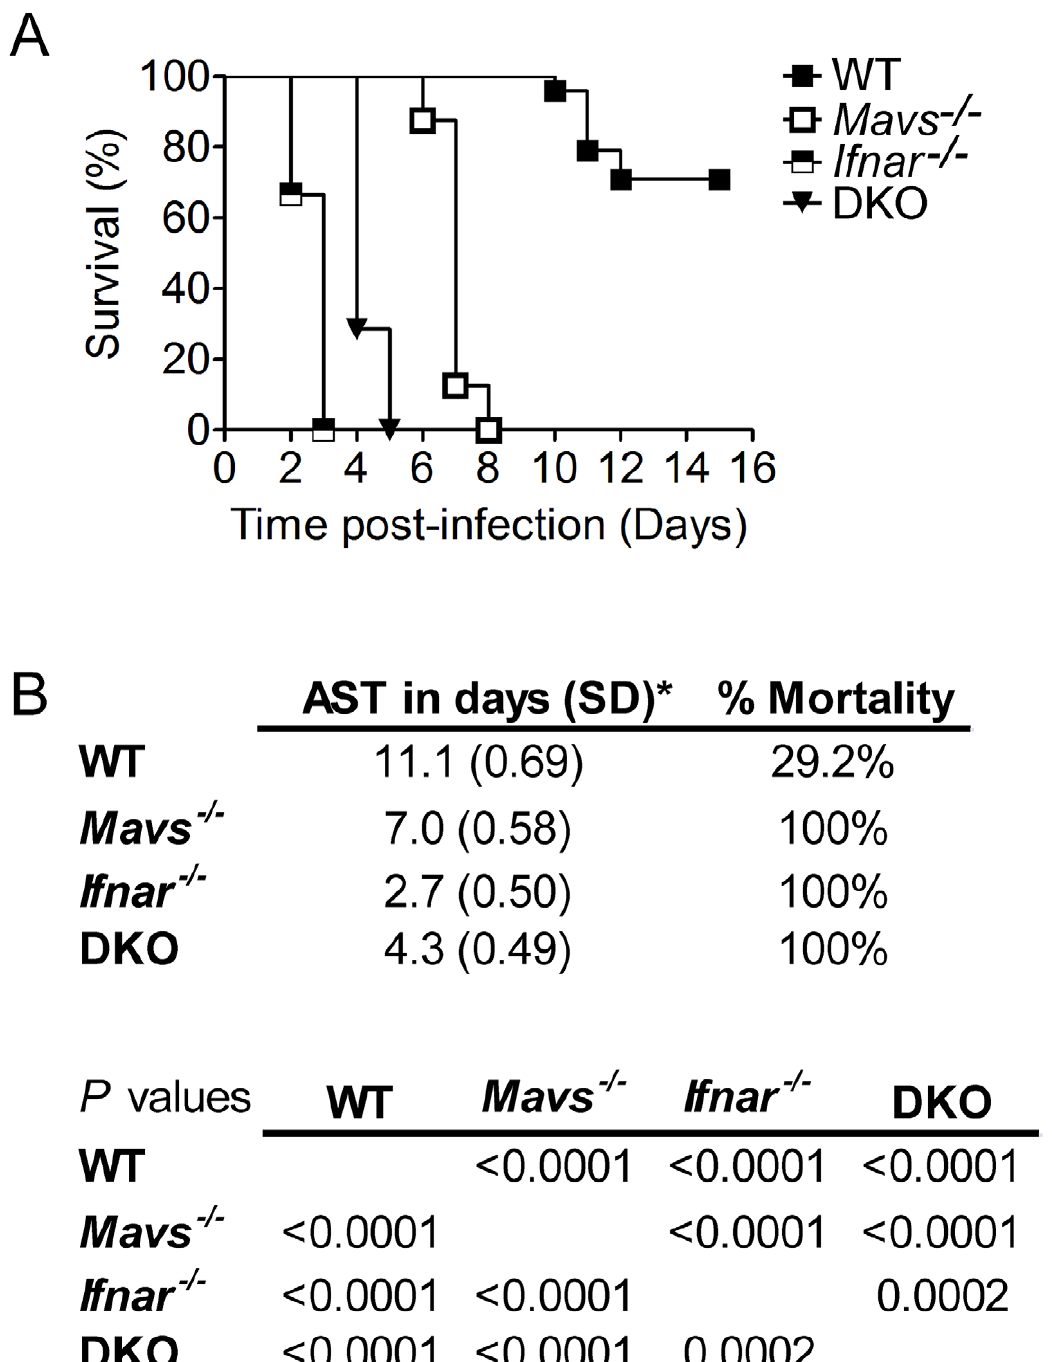
Figure 1. Enhanced virulence in mice lacking RLR and type I IFN signaling. ( A ) Survival of WT (closed squares; n=24), Mavs 2 / 2 (open squares; n=8), Ifnar 2 / 2 (half-closed square; n=9), and Mavs 2 / 2 6 Ifnar 2 / 2 (DKO; closed triangle; n=7) adult mice infected subcutaneously with 100 PFU of WNV-TX. ( B ) Upper table represents average survival time (AST), standard deviation (SD), and percent mortality. Lower table represents P values comparing WT and KO mice infected with